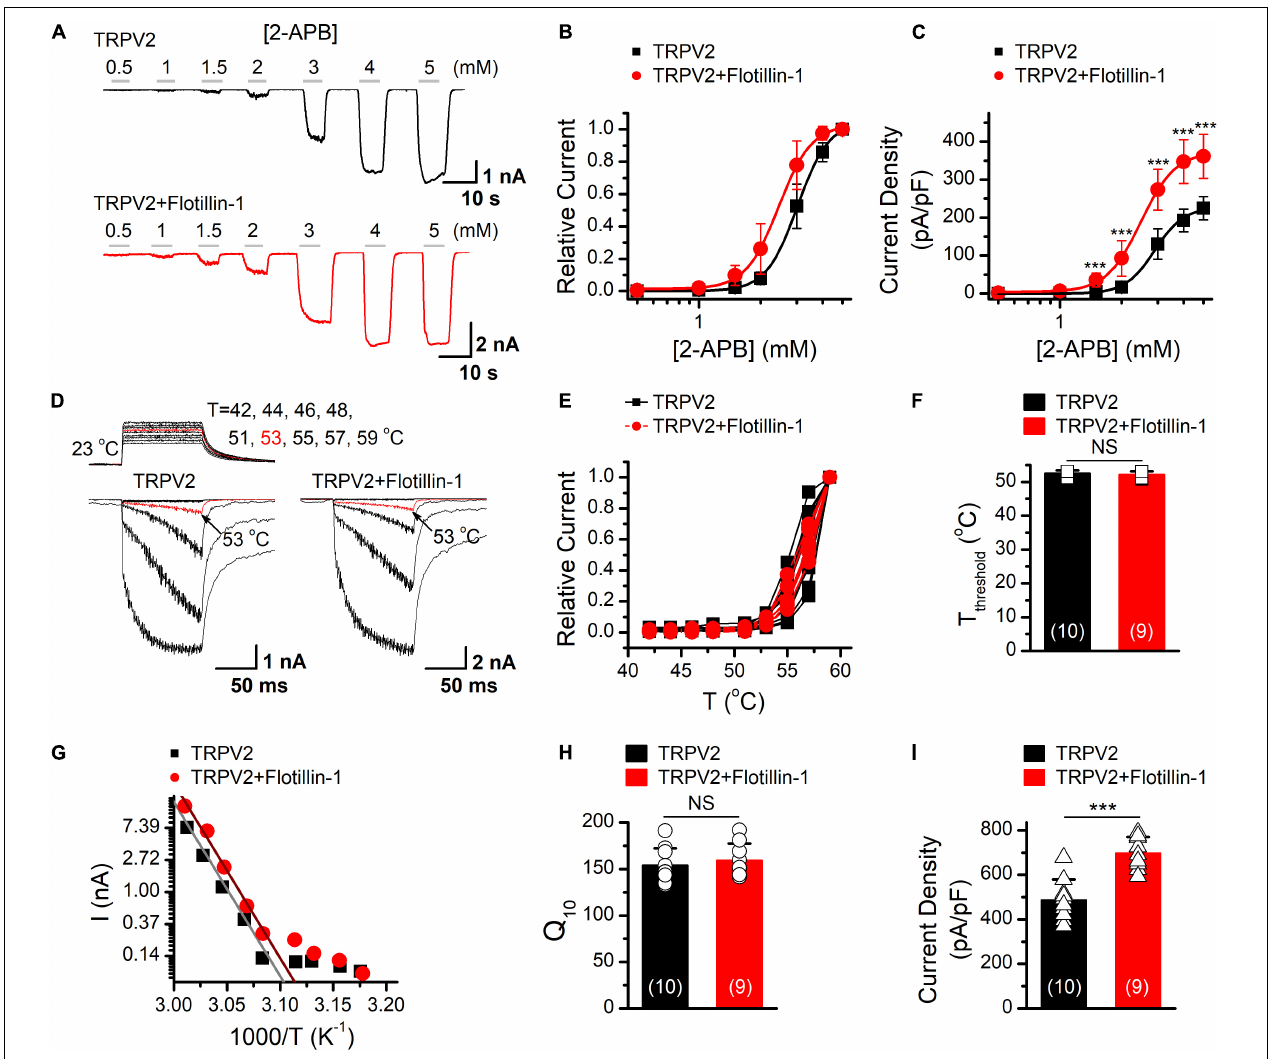
FIGURE 3 | Flotillin-1 enhances TRPV2 activity. (A) Representative whole-cell recording in HEK 293T cells expressed TRPV2 alone ( upper ), and TRPV2 + flotillin-1 ( lower ), showing that 2-APB activated TRPV2 channels in a dose-dependent manner. Holding potential was –60 mV. (B) Dose–response curves for 2-APB-evoked currents. Solid lines indicate fits with the Hill equation, which yielded EC 50 = 3.01 ± 0.04 mM, n H = 5.72 ± 0.4 for TRPV2 ( n = 8); and EC 50 = 2.44 ± 0.04 mM, n H = 5.43 ± 0.32 for TRPV2 + flotillin-1 ( n = 8). (C) Summary plot of current density. The current densities evoked by 2-APB were determined by normalizing the membrane peak current by membrane capacitance ( n = 8). *** P < 0.001. (D) Representative responses to a family of temperature jumps ranging from 42 to 57 ◦ C for HEK 293T cells that expressed TRPV2 alone (left), and TRPV2 + flotillin-1 (right). Temperature pulses stepped from room temperature were generated by laser irradiation were 100 ms long and had a rise time of 2 ms. Temperatures were calibrated offline from the pipette current using the temperature dependence of electrolyte conductivity. The red traces indicate the response at 53 ◦ C. (E) Temperature response curves for TRPV2 (black), TRPV2 + flotillin-1 (red), measured from the maximal currents at the end of temperature steps. Each curve represents measurements from an individual cell and the responses were normalized to the maximum responses at 59 ◦ C. (F) Comparison of temperature threshold for heat activation of TRPV2. Different symbols represent individual data points. The mean temperature thresholds ( T threshold ) of activation were 52.5 ± 0.8 ◦ C for TRPV2 ( n = 10), 52.1 ± 0.9 ◦ C for TRPV2 + flotillin-1 ( n = 9). P = 0.335. (G) Arrhenius plot of steady-state currents shown in (D) . The major component of the reflection that represents the strong temperature dependence was fitted to a linear equation. (H) Comparison of temperature dependence of TRPV2 and TRPV2 + flotillin-1. The values of Q10 derived from the linear fits in Arrhenius plot were as following, Q10 = 154.1 ± 18.2 for TRPV2 ( n = 10), Q10 = 159.1 ± 18.2 for TRPV2 + flotillin-1 ( n = 9). Colored symbols indicate individual data points. P = 0.566. (I) Summary of current density for temperature (59 ◦ C)-activated TRPV2 currents at –60 mV are shown. The current densities were 487.9 ± 90.8 pA/pF for TRPV2 ( n = 10) and 697.9 ± 71.5 pA/pF for TRPV2 + flotillin-1 ( n = 9); *** p < 0.001. Error bars represent